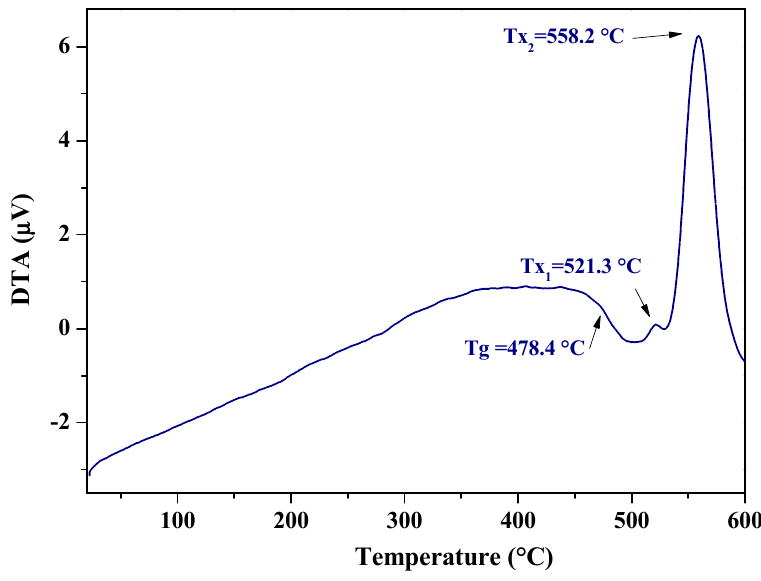
Figure 4. DTA curve of glass with nominal composition 58ZnO:4Bi 2 O 3 :4WO 3 :33.3B 2 O 3 .